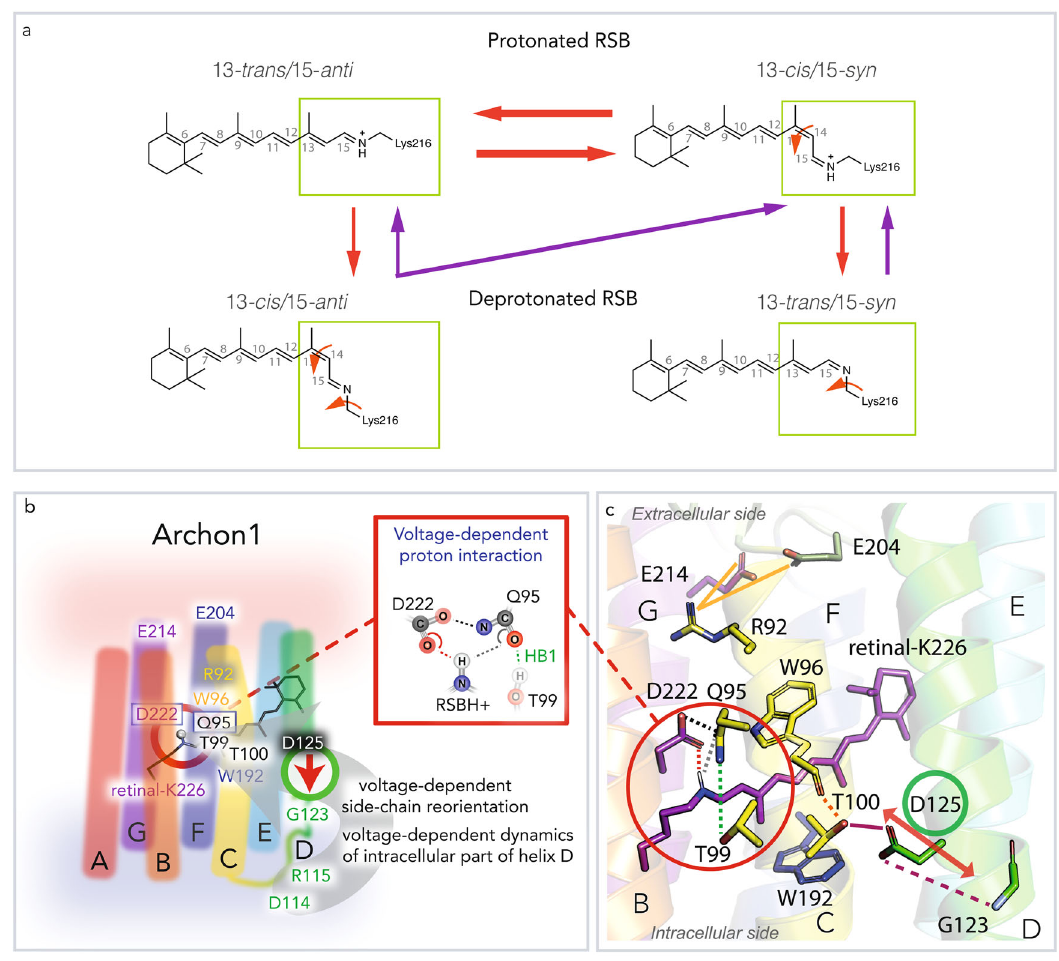
Fig. 7 | Equilibrium between retinal isomers and dynamics at the retinal binding pocket. a Proposed scheme of retinal isomer equilibrium formed after illumination. The isomerization pathways taking place after red (625nm) illumi- nation of protonated species are indicated with red arrows. The isomerization pathways taking place after blue (400nm) illumination of the deprotonated spe- cies are indicated with violet arrows. The thickness of the arrows represents the likelihoodoftheisomerizationtotakeplace,aspredictedfromHPLCanalysisofthe extracted chromophore (Fig. 2). Nevertheless, the ef fi ciency of all isomerization pathways is very low. The red illumination may induce double and single iso- merization. The more likely double isomerization would result in an equilibrium